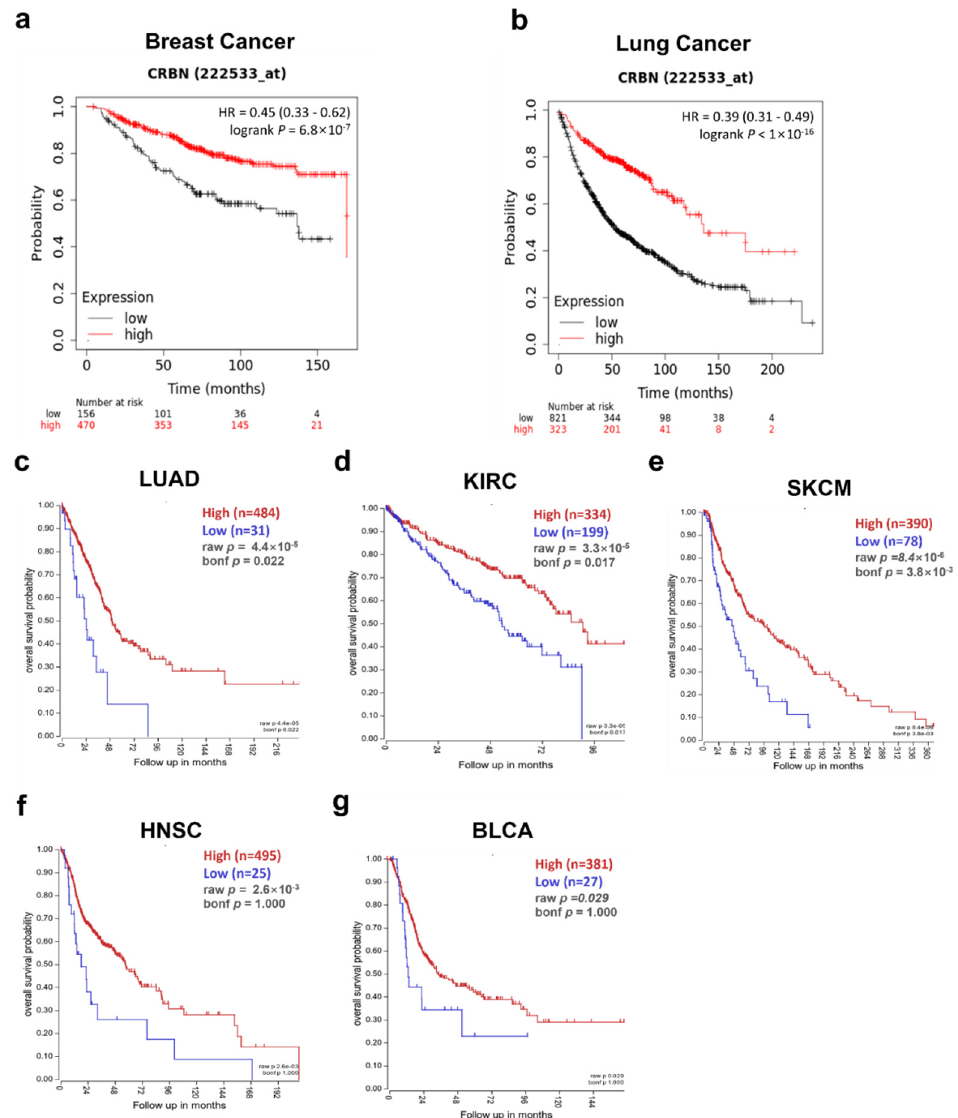
Figure 2. Correlation of CRBN expression with patient overall survival (OS) in various cancer types. OS was compared between the high expression and low expression groups using Kaplan–Meier curves. These survival curves were retrieved from the Kaplan–Meier plotter database for ( a ) breast cancer (n = 1764) and ( b ) lung cancer (n = 1144) or from the R2: platform with TCGA datasets for ( c ) lung adenocarcinoma (LUAD; n = 515), ( d ) kidney renal clear cell carcinoma (KIRC; n = 533), ( e ) skin cutaneous melanoma (SKCM; n = 468), ( f ) head neck squamous cell carcinoma (HNSC; n = 520), and ( g ) bladder urothelial carcinoma (BLCA; n = 408). All patient groups were split to minimize their p -value.